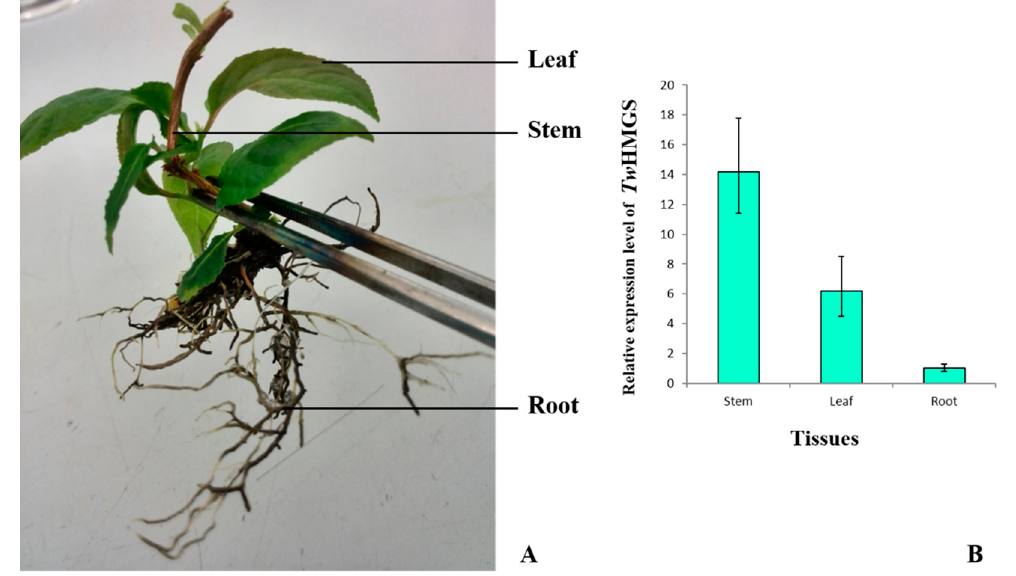
Figure 6. Expression of TwHMGS in tissues. ( A ) The T. wilfordii aseptic seedling and the tissue samples; ( B ) The relative expression of TwHMGS in different